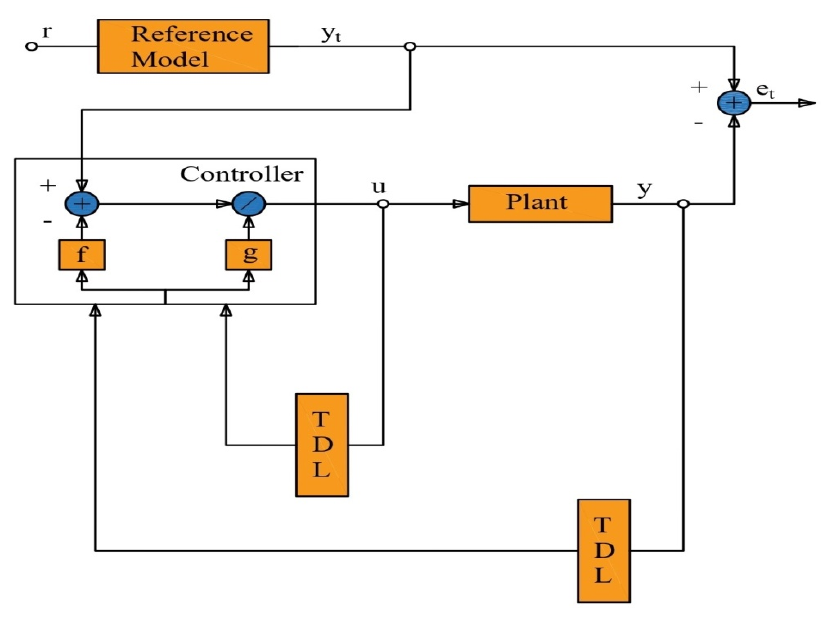
Figure 5. NARMA-L2 block diagram.